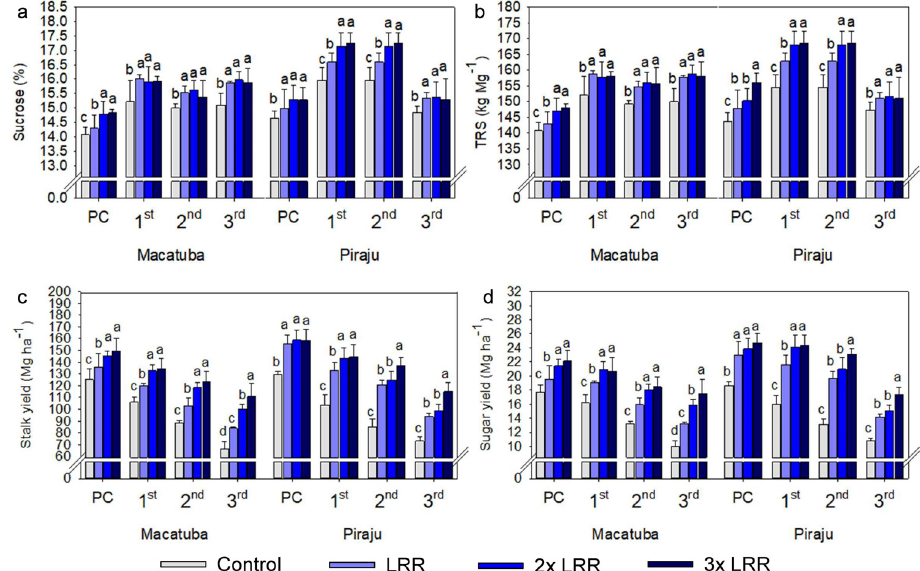
Figure 4. Sucrose ( a ), total recoverable sugar (TRS, b ), and yields of stalks ( c ) and sugar ( d ) under increasing lime rates at Macatuba and Piraju under conventional tillage (CT) in plant cane and first, second and third ratoons. Different lowercase letters indicate significant differences between lime rates for each growing season (LSD, p ≤ 0.1). The error bars express the standard error of the mean ( n = 4).